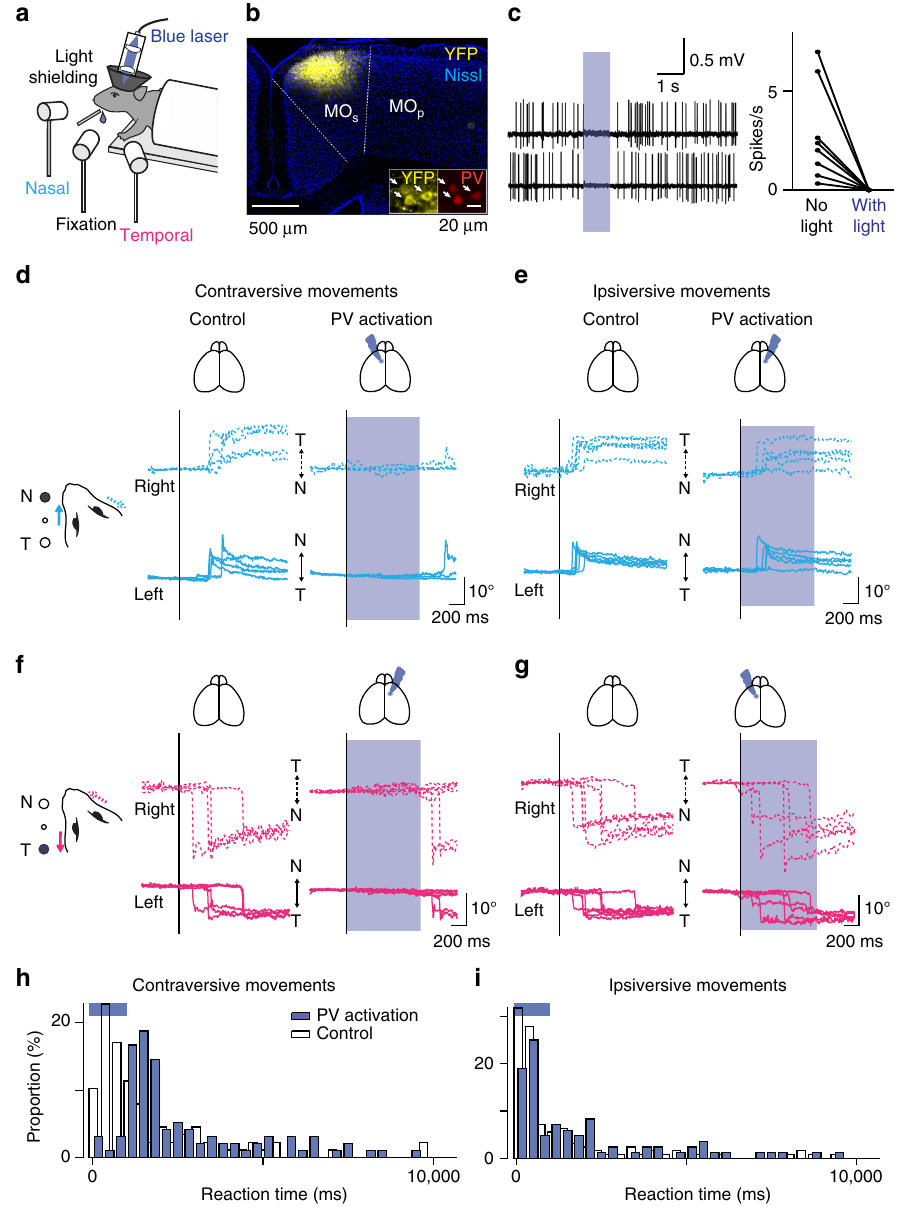
Fig. 2 Optogenetic suppression of the MO s during the visually guided eye movement task. a The experimental design. b ChR2 was expressed virally in PV interneurons in Pvalb -IRES-Cre transgenic mice. AAV-DIO-ChR2-eYFP was injected into the MO s (coronal section stained with Nissl), and ChR2-eYFP expression was con fi ned to cells expressing PV (white arrows). c Firing was suppressed during blue light illumination. Left, two representative neurons are shown. Right, blue light illumination completely suppressed fi ring activity in all eight neurons ( p < 0.01, Wilcoxon signed-rank test). The activity was monitored with blind cell-attached recording. d – g Optogenetic suppression of the MO s during the task. The virus was injected into the MO s either in the left ( d , g ) or right ( e , f ) hemisphere. Unilateral suppression of the MO s severely impaired eye movements in the contraversive ( d , f ) but only mildly in the ipsiversive ( e , g ) direction. h , i Reaction times for the eye movements. PV activation delayed the onset of contraversive eye movements ( h , PV activation, n = 96 trials; control, n = 88 trials; p < 10 − 11 ), but showed only minor effects on ipsiversive movements ( i , PV activation, n = 84 trial; control, n = 126 trials; p = 0.0501, Person ’ s chi-square